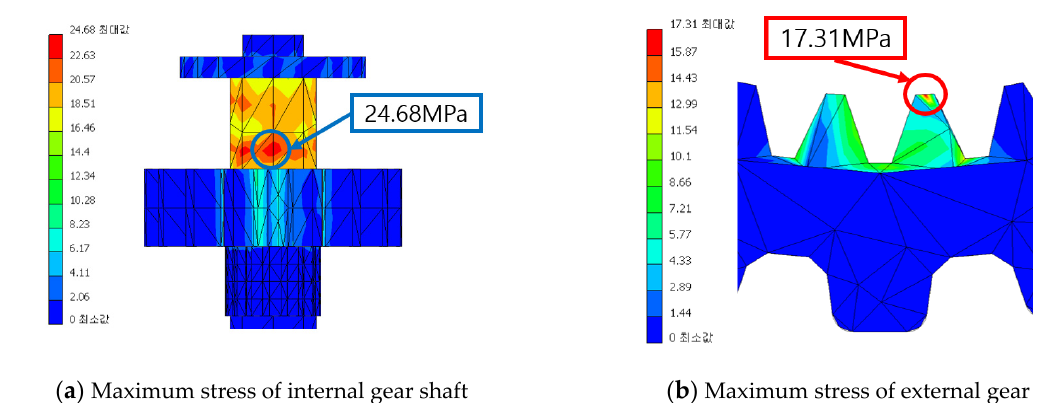
Figure 9. Results of stress analysis. ( a ) Maximum stress of internal gear shaft. ( b ) Maximum stress of external gear.